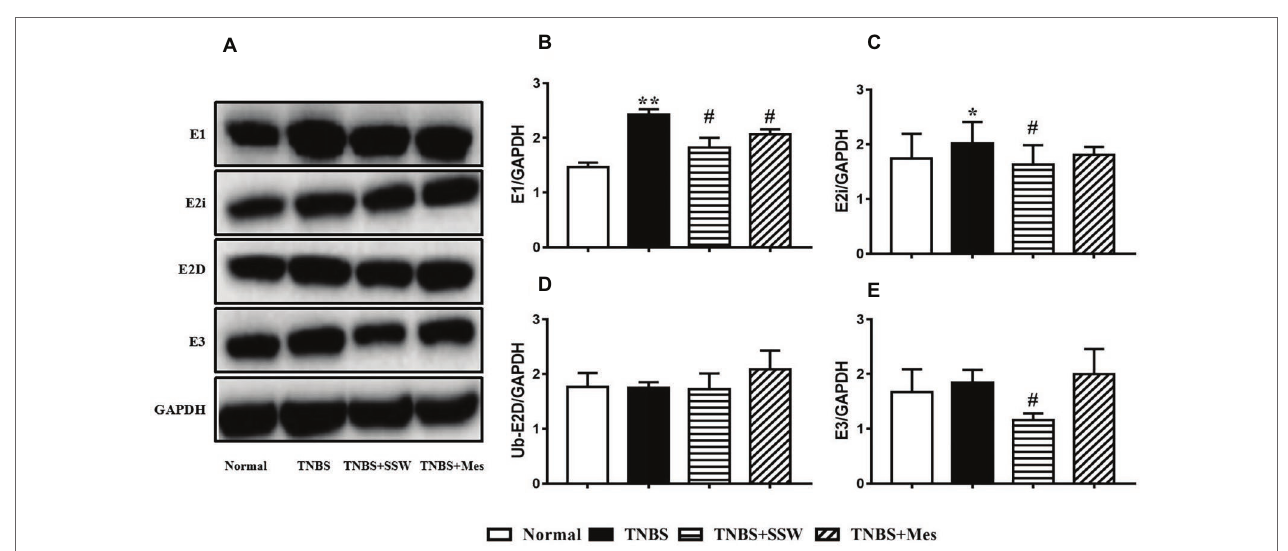
FIGURE 5 | Western blot analysis of E1, E2i, E2D, and E3. (A) Western blotting of E1, E2i, E2D, and E3. (B) Quantitative analysis of E1. (C) Quantitative analysis of E2i. (D) Quantitative analysis of E2D. (E) Quantitative analysis of E3. Data were presented as mean ± SEM ( n = 6). * p < 0.05 and ** p < 0.01 versus the Normal group; # p < 0.05 versus the TNBS